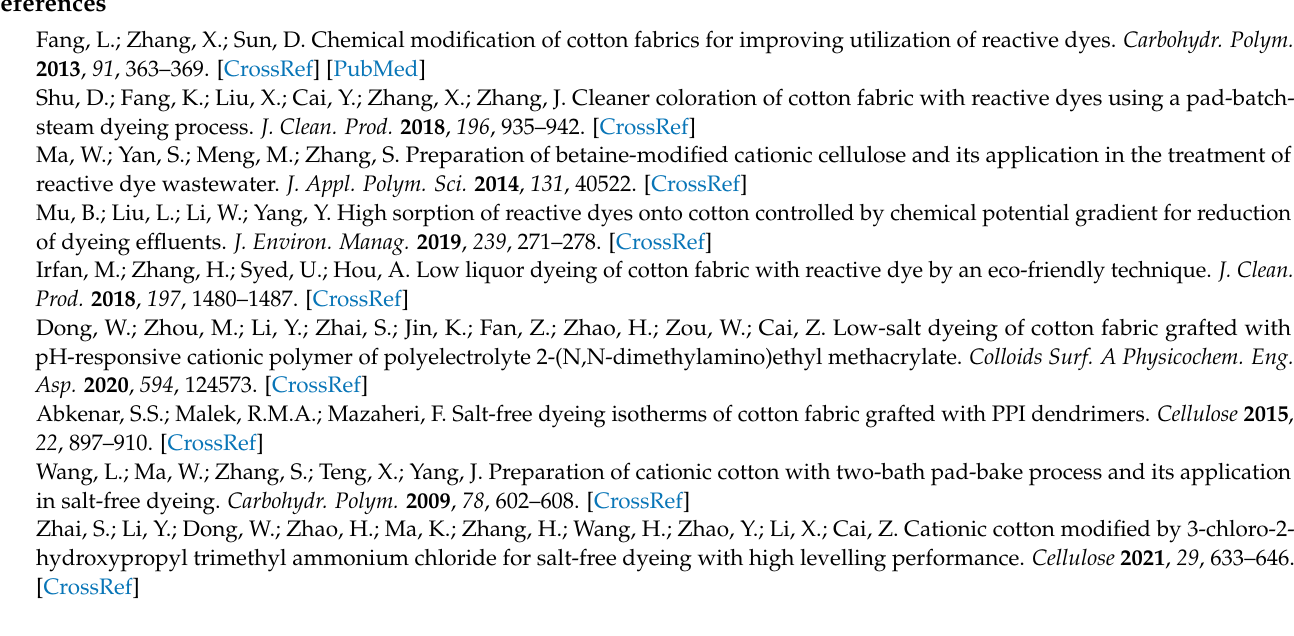
ization process; Figure S2: Chemical structure of C.I. Reactive Black 5; Figure S3: Schematic dia- gram of the conventional dyeing and soaping process; Figure S4: Partial enlargement of Figure 6a; Figure S5: Partial enlargement of Figure 6b; Table S1: Cationic reagent dosage comparison between different